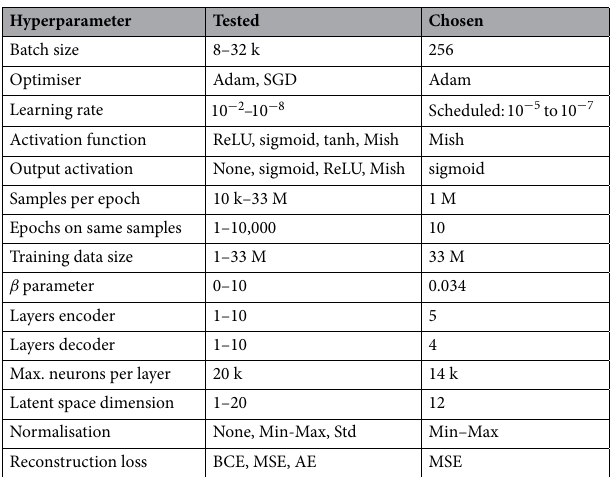
Table 1. Hyperparameter optimisation: in order to find the best network, the shown hyperparameters were varied in the given